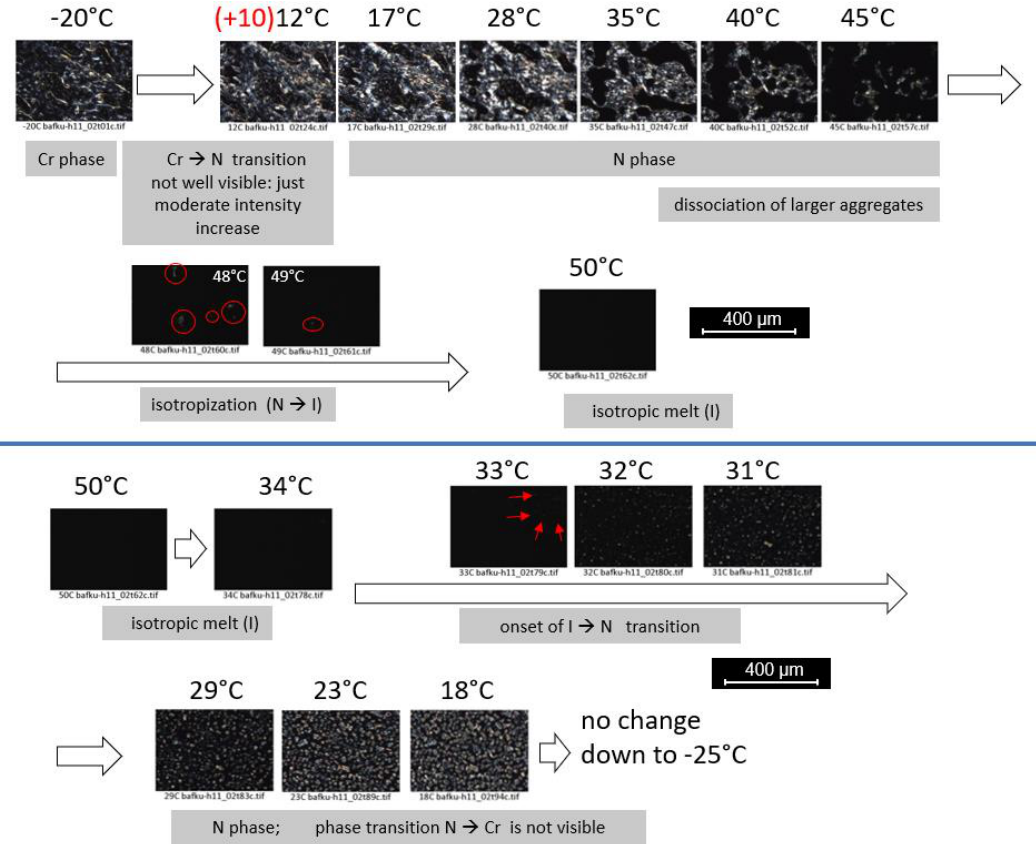
Figure 7. Textures observed in BAFKU–H11. Top : heating run; bottom : cooling run; large Figure7. TexturesobservedinBAFKU–H11. Top : heatingrun; bottom : coolingrun;